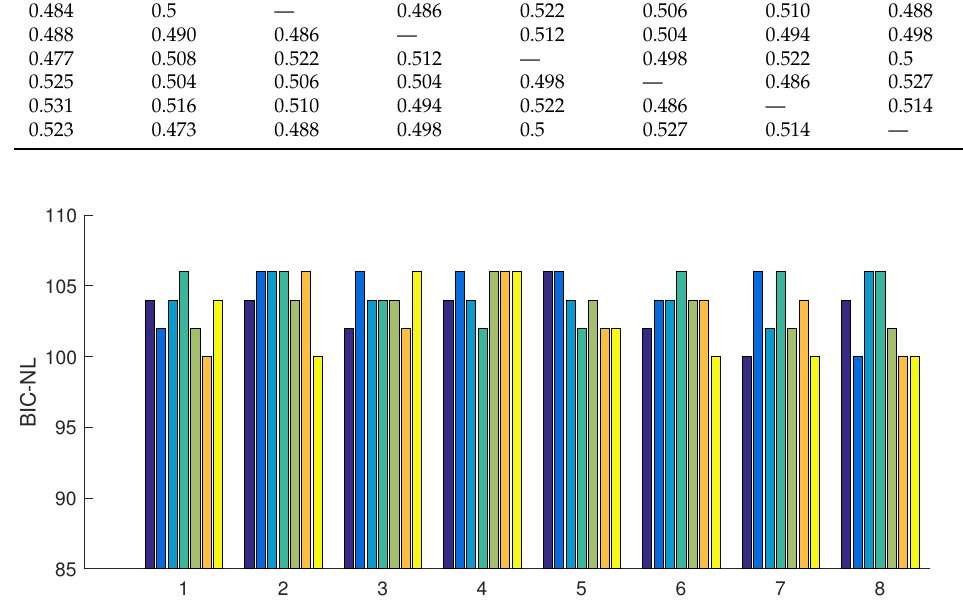
Figure 5. A bar chart of the BIC-NL of the newly designed S-box σ . The minimum BIC-NL of each component is 100 and maximum is 106, as